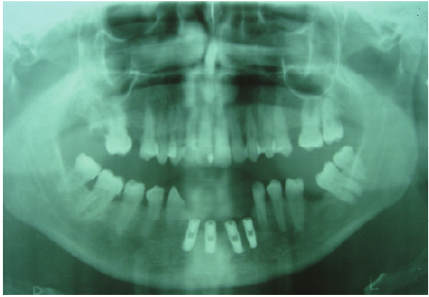
Figure 1: OPT after implant placement.